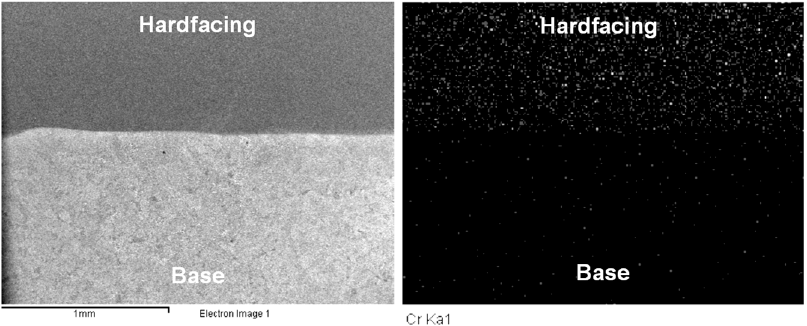
Figure 4. Scanning electron microscope with energy-dispersive X-ray spectrometer (SEM-EDS) mapping with the Cr element of S1 at the interlayers of the base metal and hardfacing.